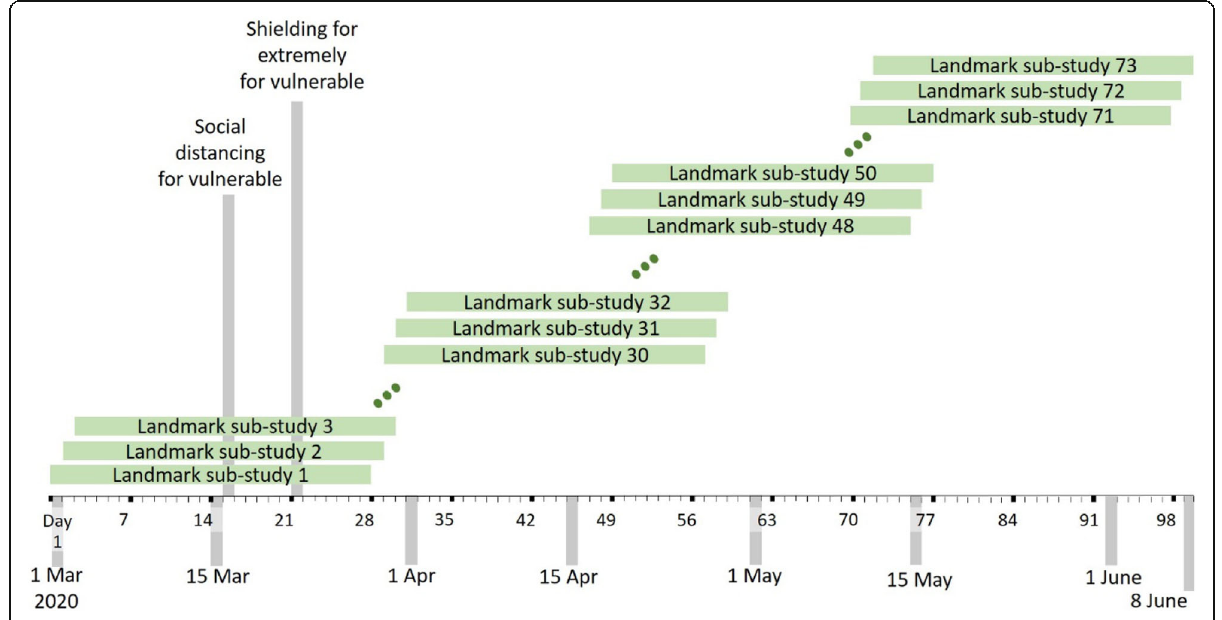
Fig. 1 Schematic showing the design of the 28-day landmarking sub-studies (approach